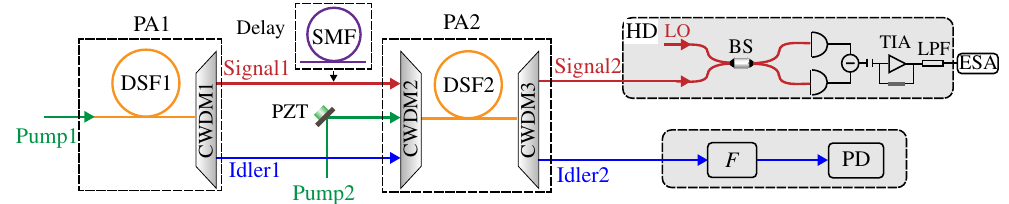
FIG. 4. Experimental setup for observing quantum interference in the SU(1,1) interferometer, which is unbalanced when a 4.08- m-long single-mode fiber (SMF) is inserted to introduce one pulse delay in the signal (or idler) channel between two PAs. PA1-2, parametric amplifier; DSF1-2, dispersion-shifted fiber; PZT, piezoelectric transducer; CWDM1-3, coarse wavelength division multi- plexer; SMF, single-mode fiber; F, filter; PD, power detector; HD, homodyne detection; BS, beam splitter; LO, local oscillator; TIA, transimpedance amplifier; LPF, low-pass filter; ESA, electronic spectrum analyzer.